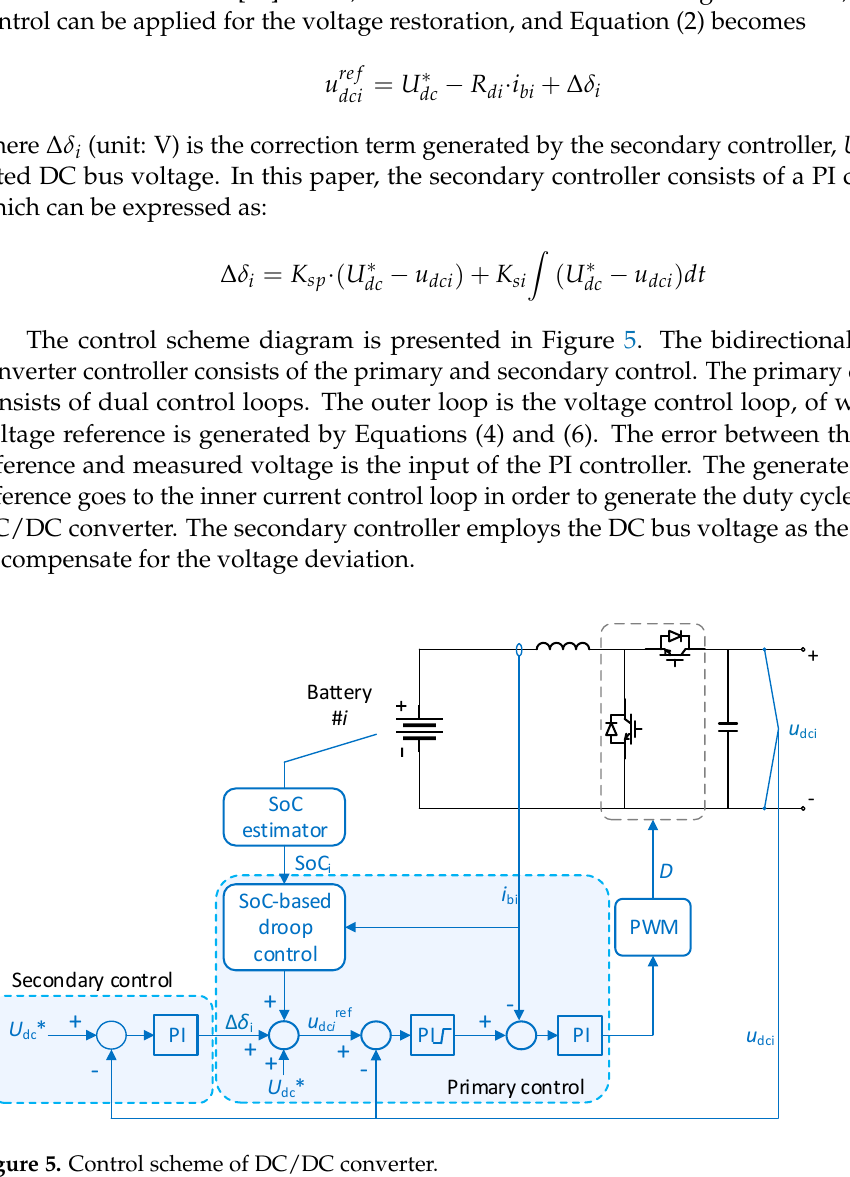
Figure 5. Control scheme of DC/DC converter.